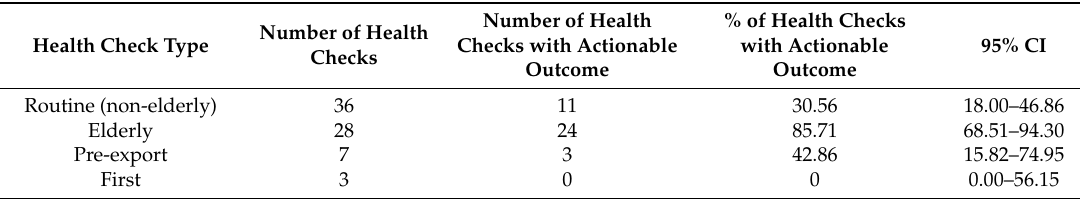
Frequency of health check types and proportion of health checks resulting in an actionable outcome.